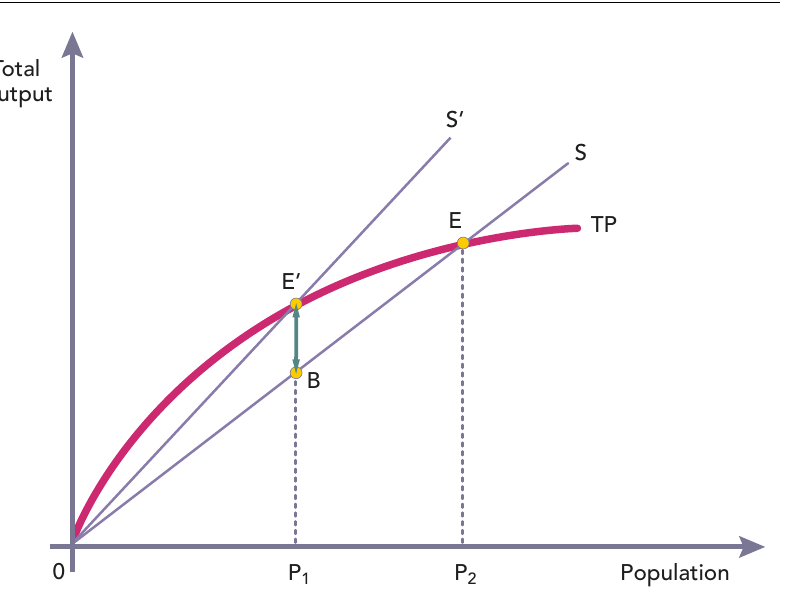
Figure 3. Equilibrium with stable